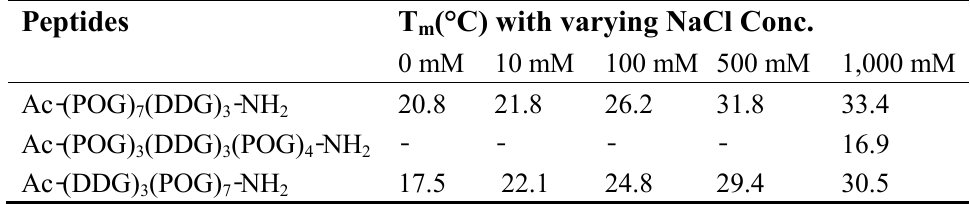
Table 1. Melting temperature (T